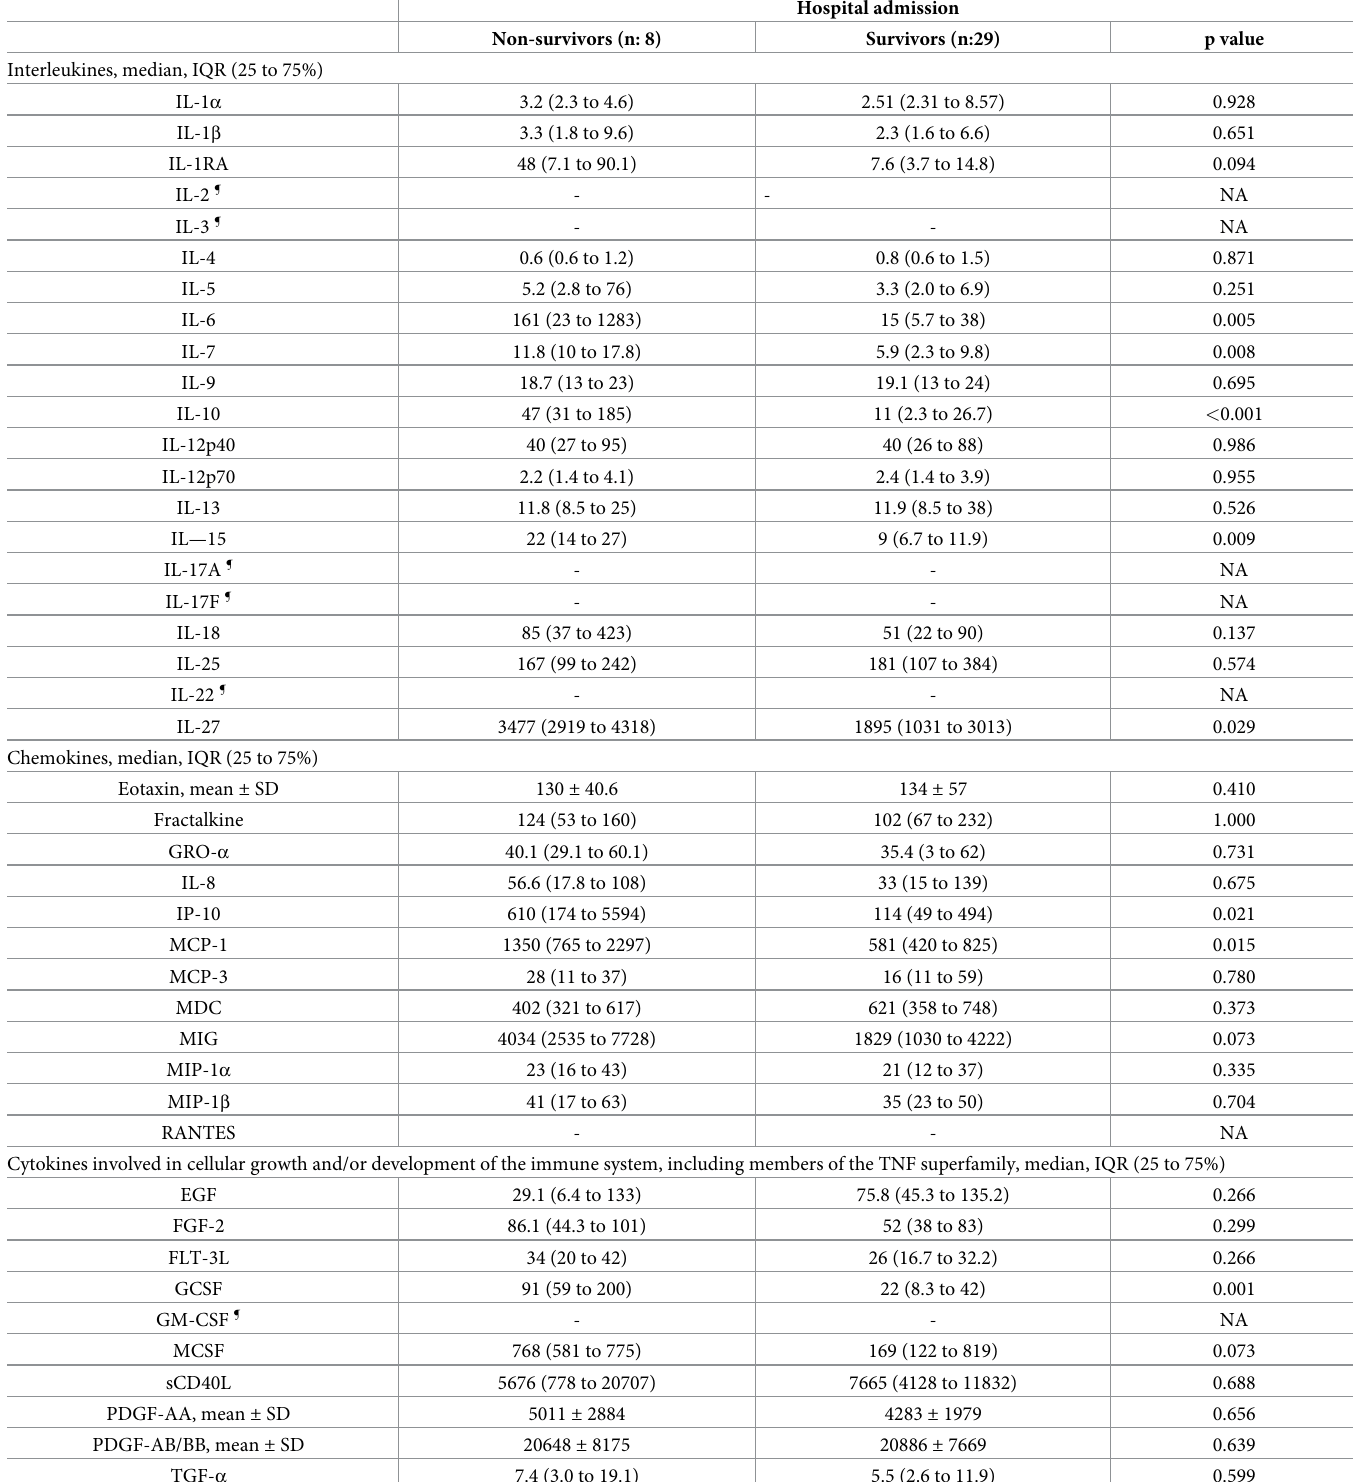
Table 2. The cytokine levels of COVID-19 patients according to